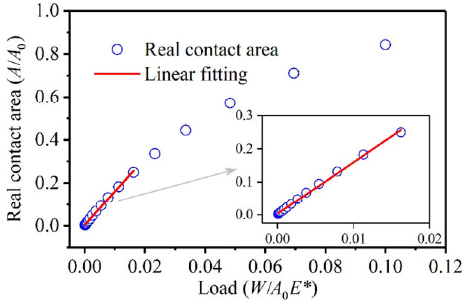
Fig. 5 Real contact area as a function of load.